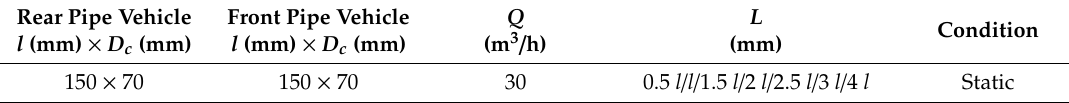
Table 2. Experiment plan.